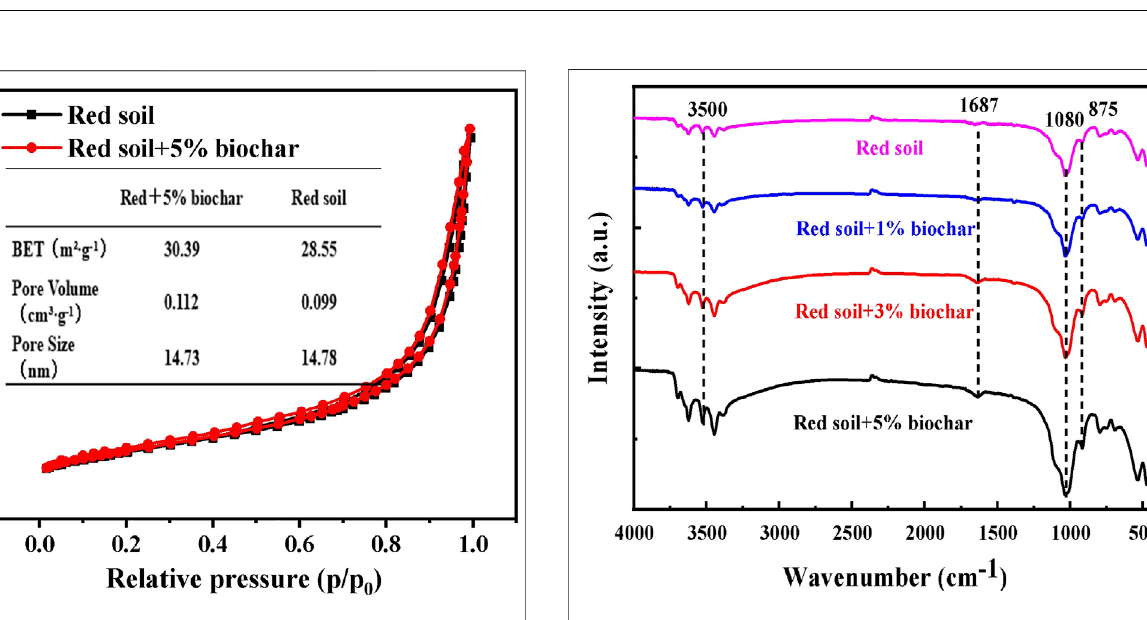
FIGURE 3 | FTIR analysis of the rice straw biochar-amended red